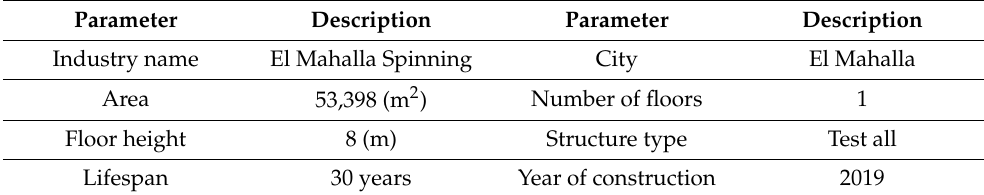
Table 10. General parameters of the tested case